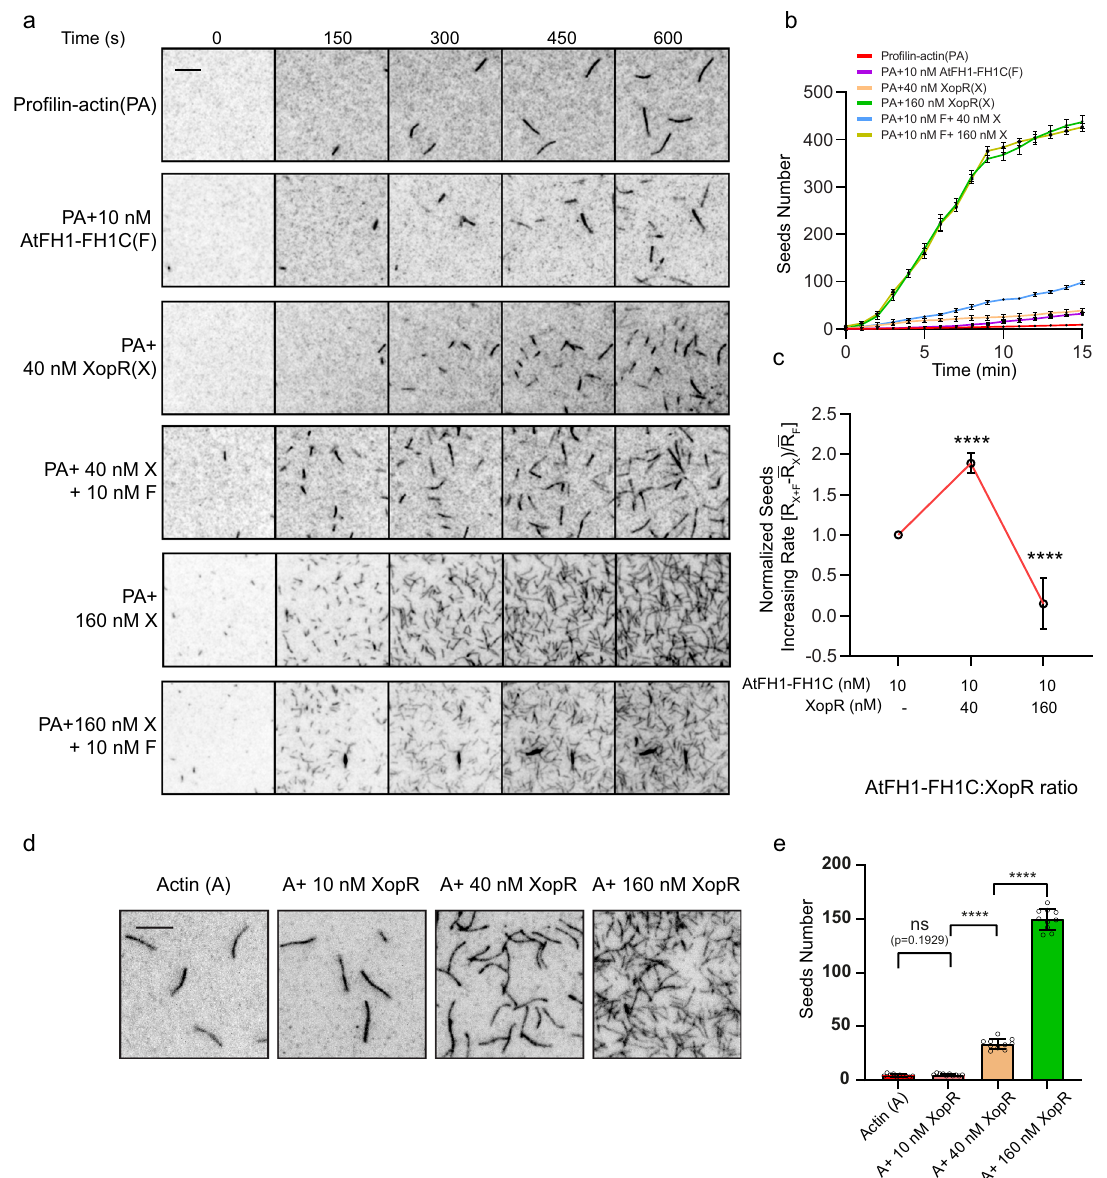
Fig. 4 XopR modulates AtFH1-mediated actin nucleation in the TIRF-actin assembly assay. a Representative time-lapse images from TIRFM where 0.5 μ M G-actin (10% Oregon-actin) was incubated with 2 μ M AtPRF1 and polymerized in the presence of the indicated concentrations of AtFH1-FH1C and XopR. b Actin seed number quanti fi cation in the area of 22 × 22 μ m 2 from a ( n = 6, Error bar, SD). c Normalized actin seed increasing rate calculated from b ( n = 6, Error bar, SD). Scale bar = 5 μ m for a . d Representative images from TIRFM experiments where 0.5 μ M G-actin (10% Oregon-actin) was polymerized in the presence of the indicated concentration of XopR for 300 s. e Quanti fi cation of actin seed number in the area of 22 × 22 μ m 2 from d ( n = 10, Error bar, SD). Scale bar: 5 μ m for a and d . Two-tailed Student ’ s t -test was performed assuming equal variance. Ns no signi fi cant difference, * p <